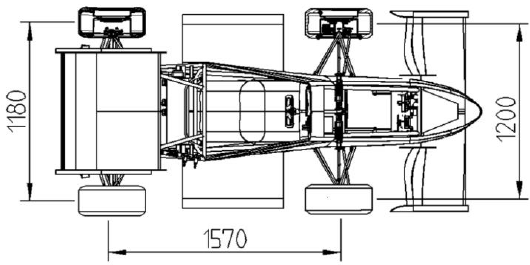
Figure 2. Sketch of vehicle dimensions.